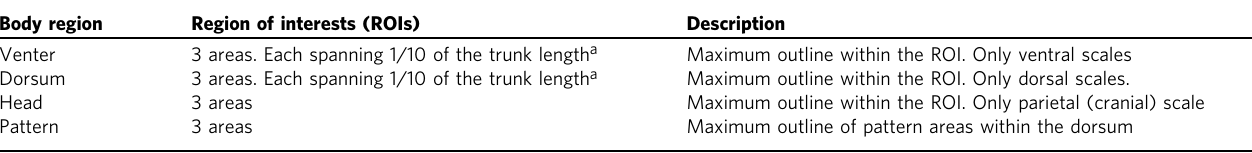
Table 1 Data acquisition in